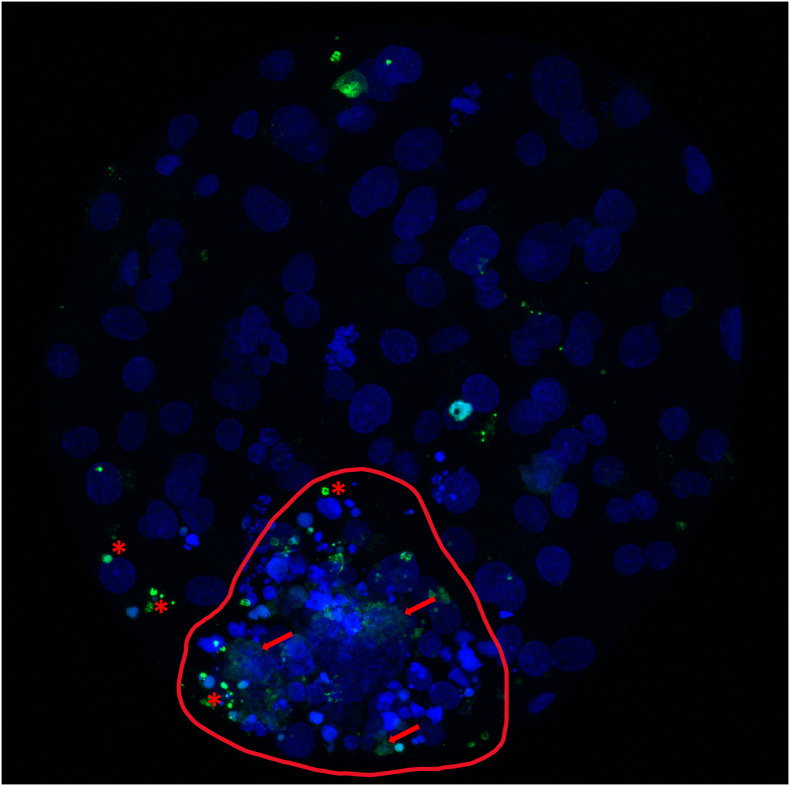
Cell death analysis in a bovine expanded blastocyst produced in vitro. Bovine expanded blastocyst produced in vitro and stained with bisbenzimide (blue) to visualize all nuclei and TdT-mediated dUTP nick-end labeling (TUNEL; green). Red asterisks mark TUNEL-positive nuclei undergoing the apoptotic pathway (condensed, TUNEL-positive structures that can appear scattered as smaller apoptotic bodies and correspond to chromatin and cytoplasmic condensation, with intact nuclear membrane). Red arrows mark nuclei undergoing necrosis (TUNEL-positive structures, with unclear, swollen and frayed edges; red arrows). The inner cell mass (circled, red line) shows the highest incidence of identified and non-recognizable forms of cell death, in contrast with a lower incidence in the more abundant trophectoderm cells.